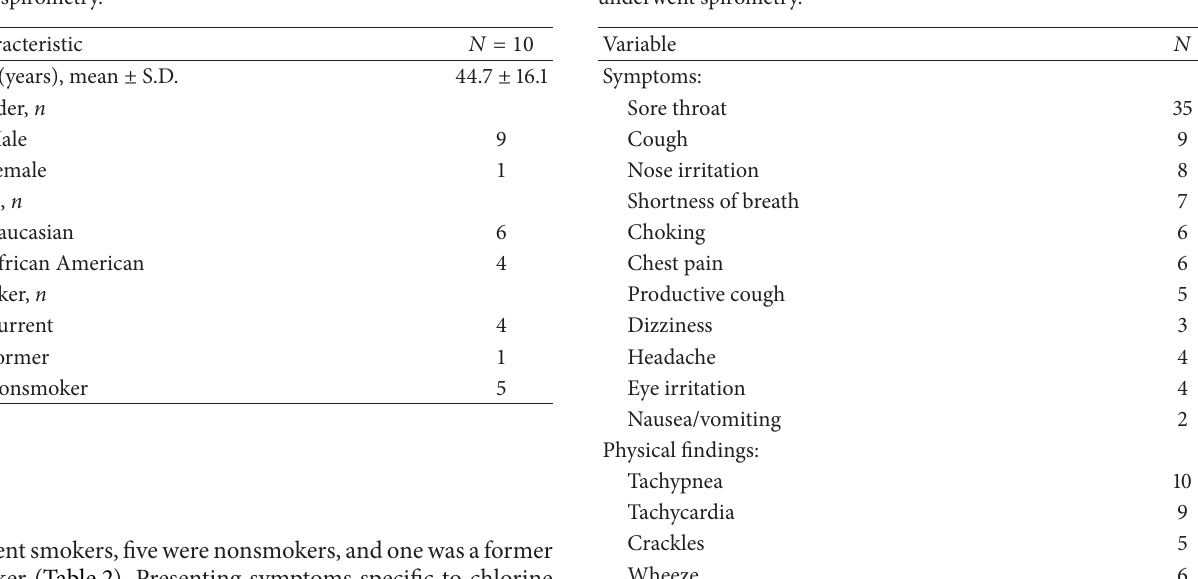
Table3:Presentingsymptomsandphysicalfindingsinpatientswho underwent